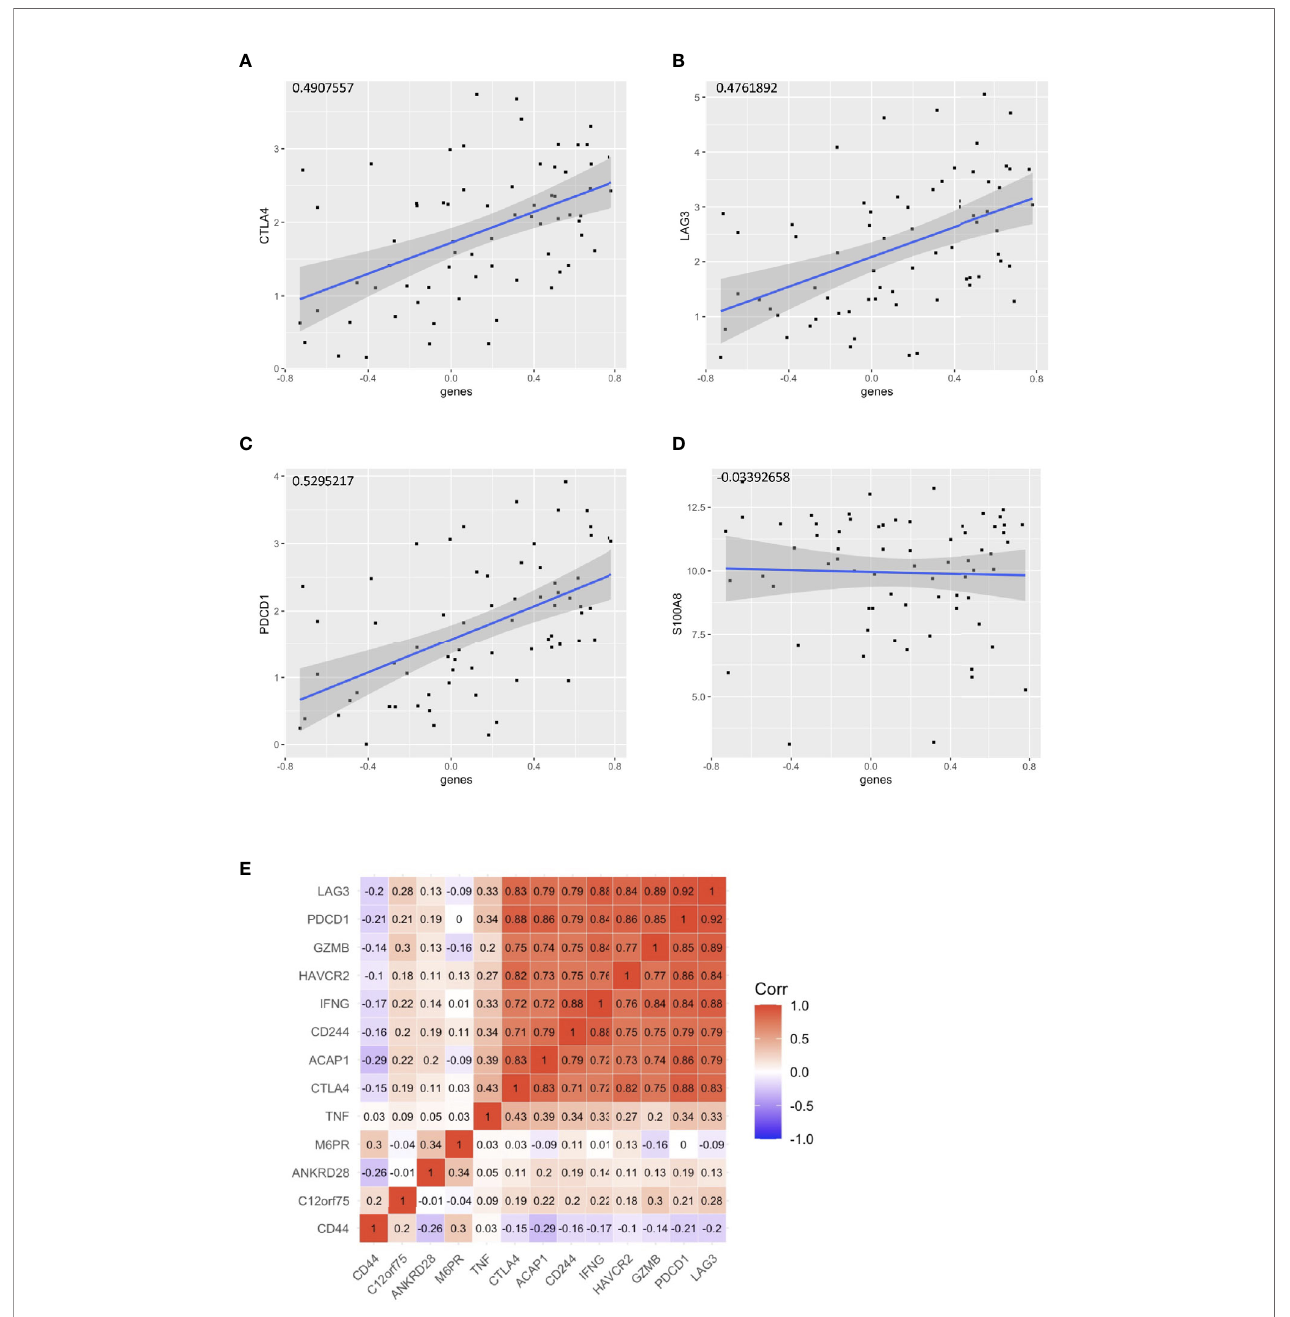
FIGURE 8 | Correlation of the signature genes with the checkpoint related genes. Correlation of the signature genes with (A) CTLA4 (B) LAG3 and (C) PDCD1. (D) S100A8 was used as control. (E) A corr plot showing the signature genes with the checkpoint related